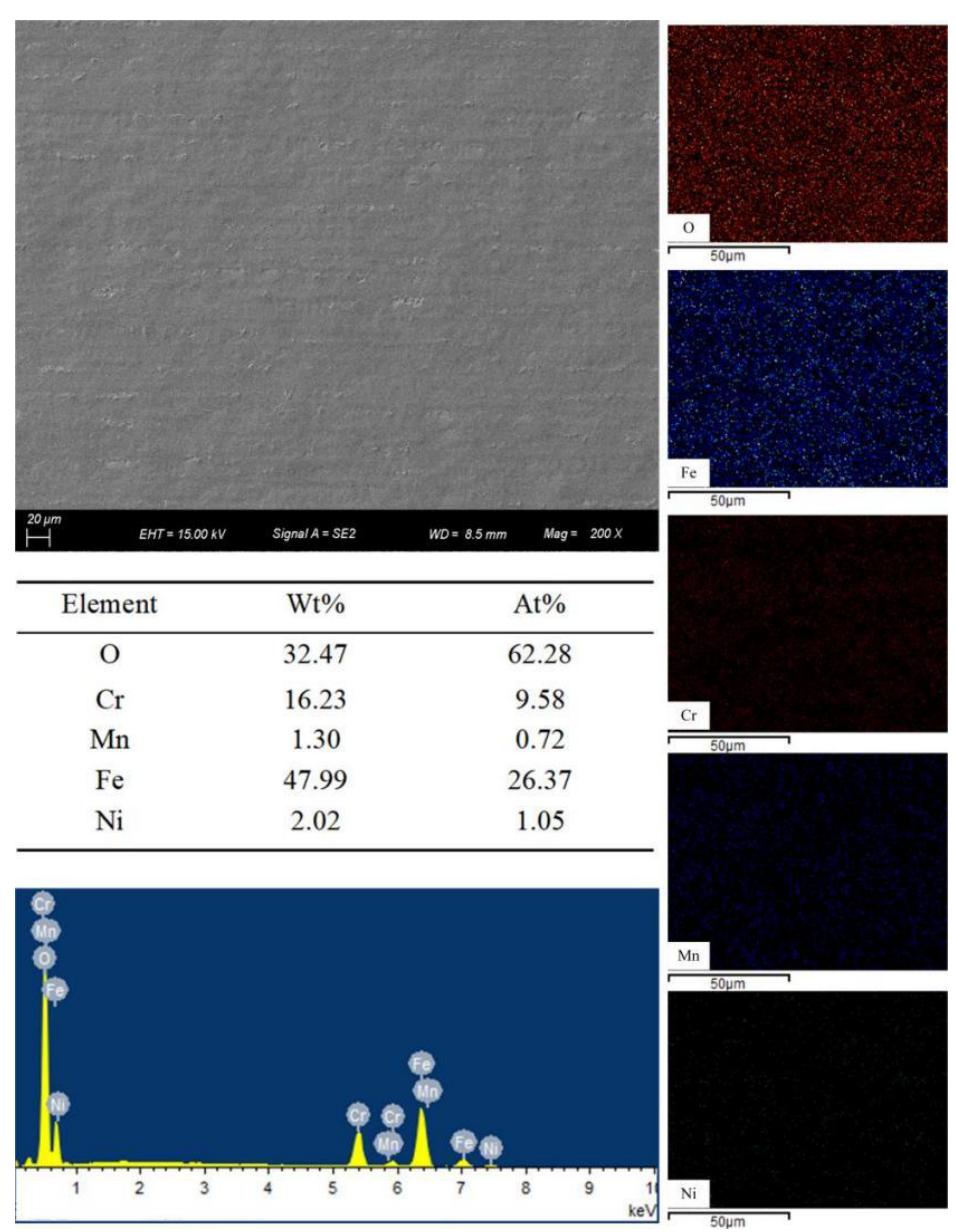
Figure 9. Micromorphology and EDS analysis after laser surface remelting with “S” scanning path.